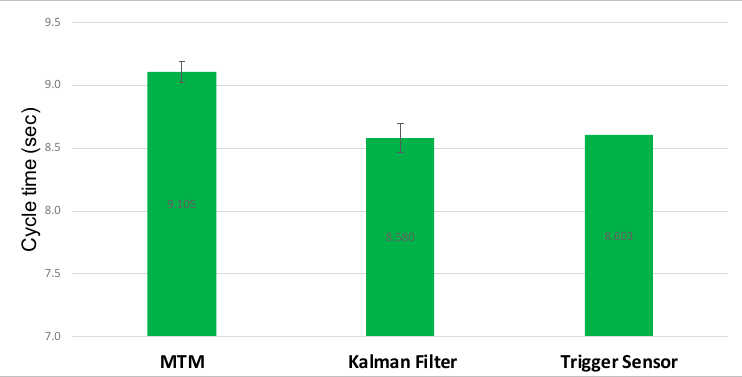
Figure 10. Cycle time for three handover prediction models.